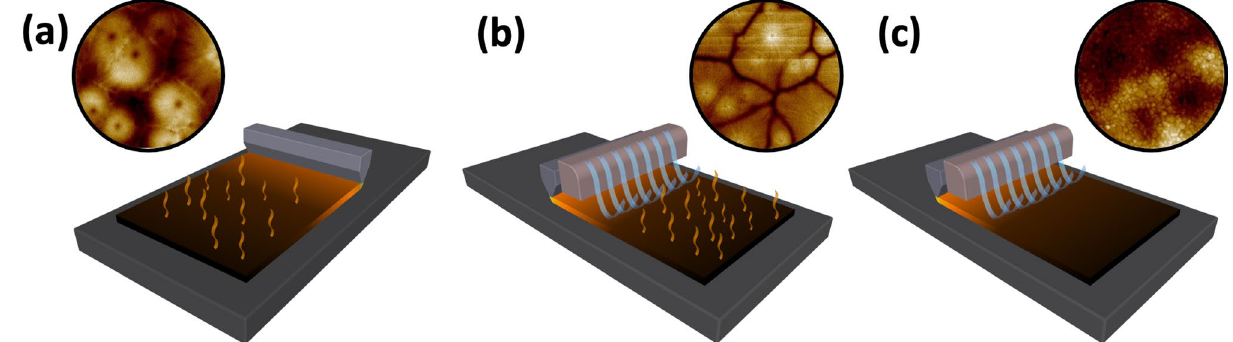
Figure 1. Schematic representation of different coating conditions used in this study: ( a ) coating at elevated temperature without N 2 gas blowing; ( b ) coating at elevated temperature with N 2 gas blowing; and ( c ) coating at room temperature with N 2 gas blowing.